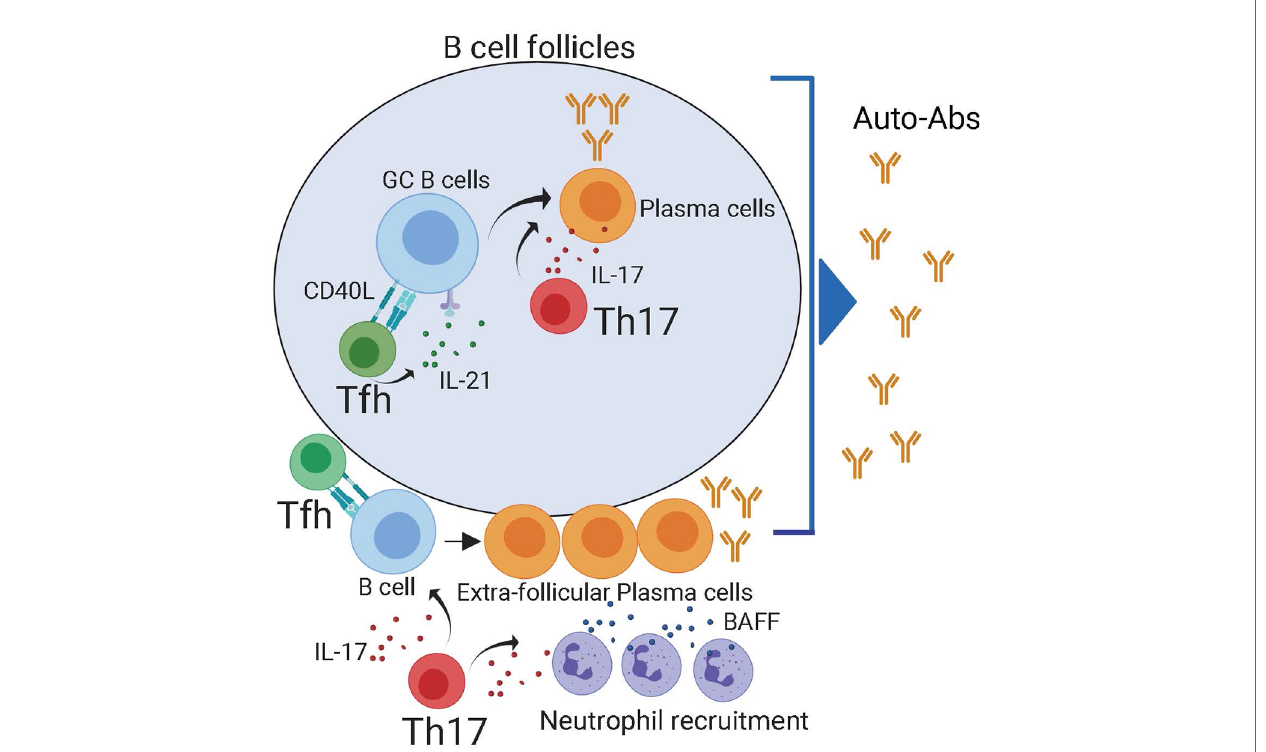
FIGURE 2 | Both follicular and extra-follicular pathways contribute to auto-antibody production. Within the B cell follicles, Tfh cells maintain auto-reactive germinal center reactions which generate self-reactive plasma cells. Tfh cells can also provide help in to extra-follicular PCs in the B cell border. Reports have demonstrated that IL-21 produced by Th17 cells can also contribute to the production of self-reactive plasma cells in the follicle. Besides, in the extra-follicular space, IL-17 produced by Th17 recruits BAFF producing neutrophils. The combination of IL-17, BAFF, and Tfh cells promotes the generation of self-reactive plasma